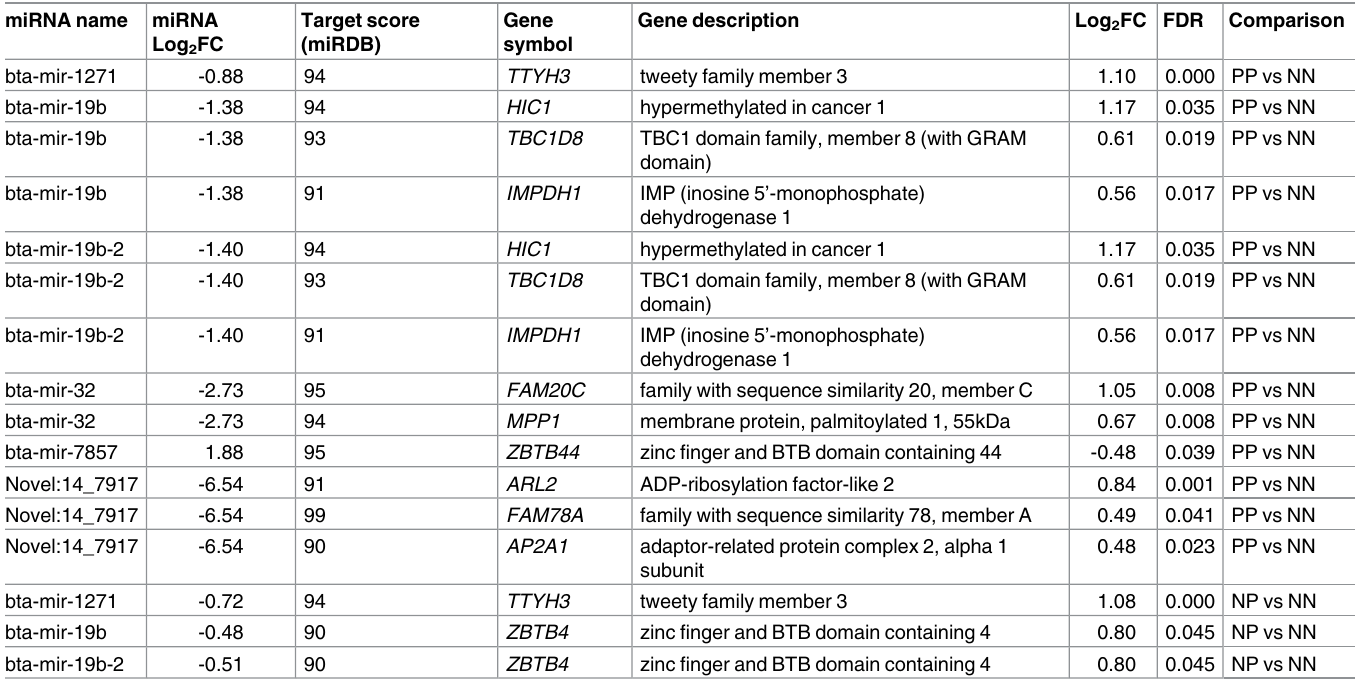
Table 5. Correlation between miRNAs and predicted target